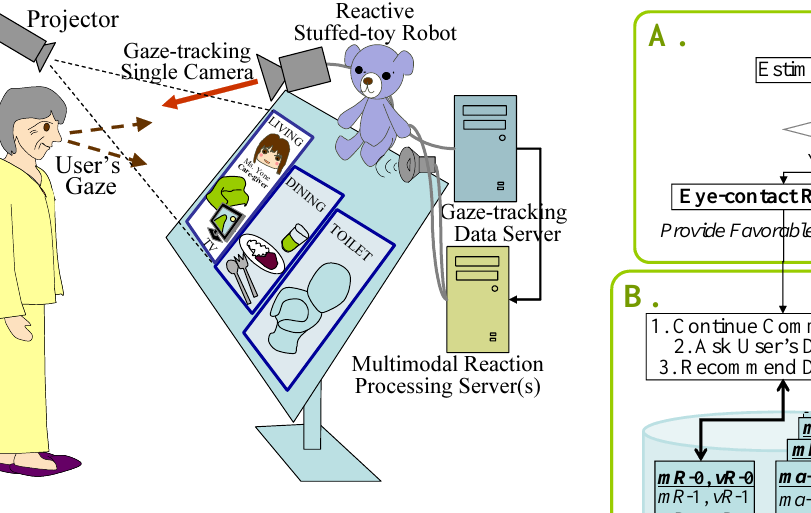
Figure 3. The GazeRoboard System Structure